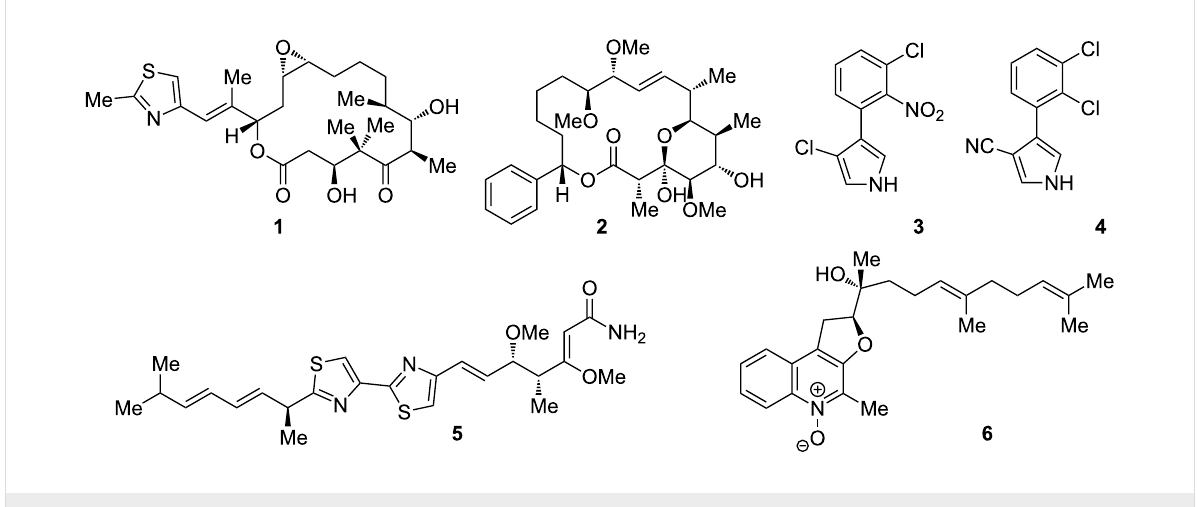
Figure 1: Structures of epothilone A ( 1 ), soraphen A 1 α ( 2 ), pyrrolnitrin ( 3 ), fenpiclonil ( 4 ), myxothiazol A ( 5 ), and aurachin A ( 6 ).